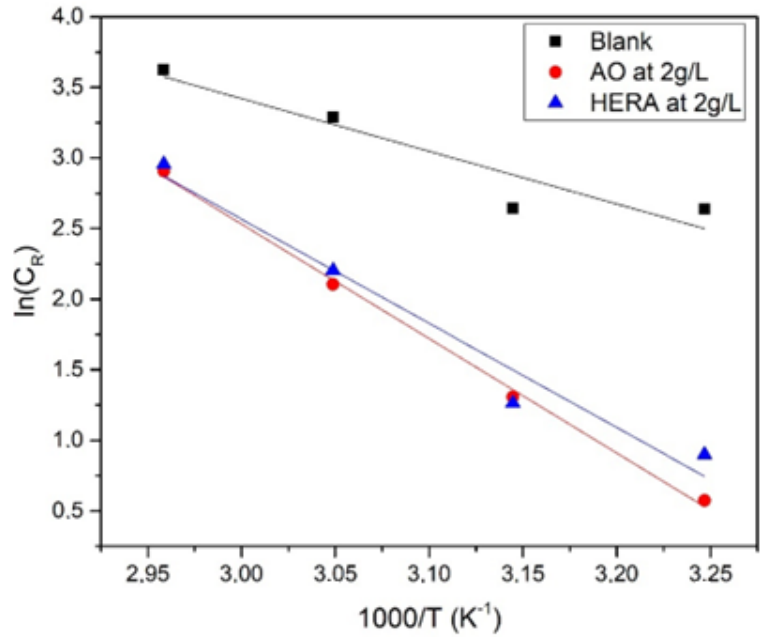
Figure 3. Arrhenius plots for mild steel in 1 M HCl in the absence and the presence of AO and HERA.